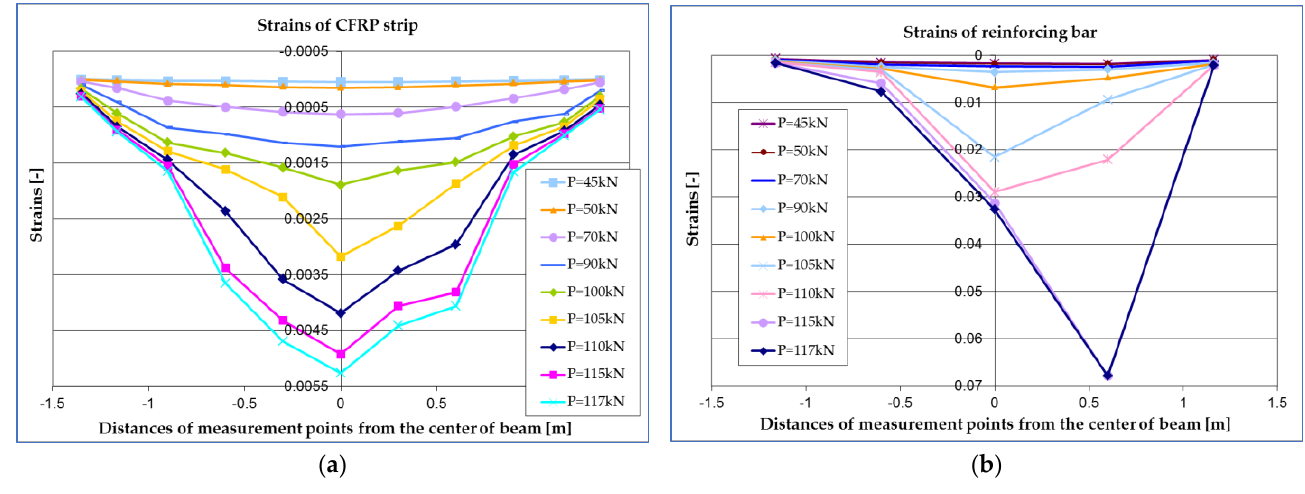
Figure 10. Strains in Bopw-1 beam: ( a ) of composite strip and ( b ) of middle reinforcing bar.